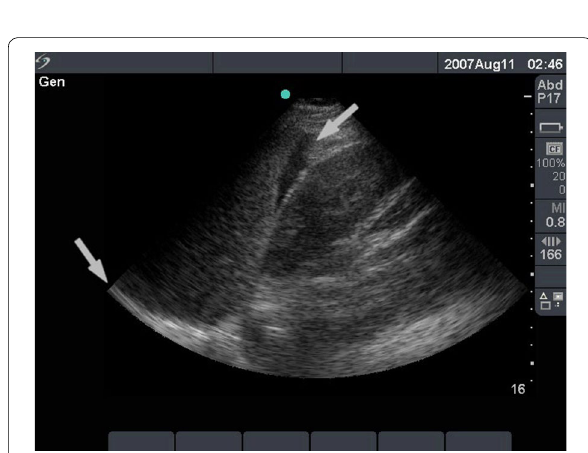
Fig. 8 Hemoperitoneum at the splenorenal recess. An ultrasound image of the splenorenal recess (Koller’s pouch). A phased‑array cardiac transducer was used with the abdominal settings. The left arrow indicates the diaphragm. The right arrow indicates the splenorenal recess with a hypoechoic collection between the spleen (left) and the left kidney (right). This is the image of free intraperitoneal fluid and is very suggestive for intraperitoneal hemorrhage when encountered in a trauma